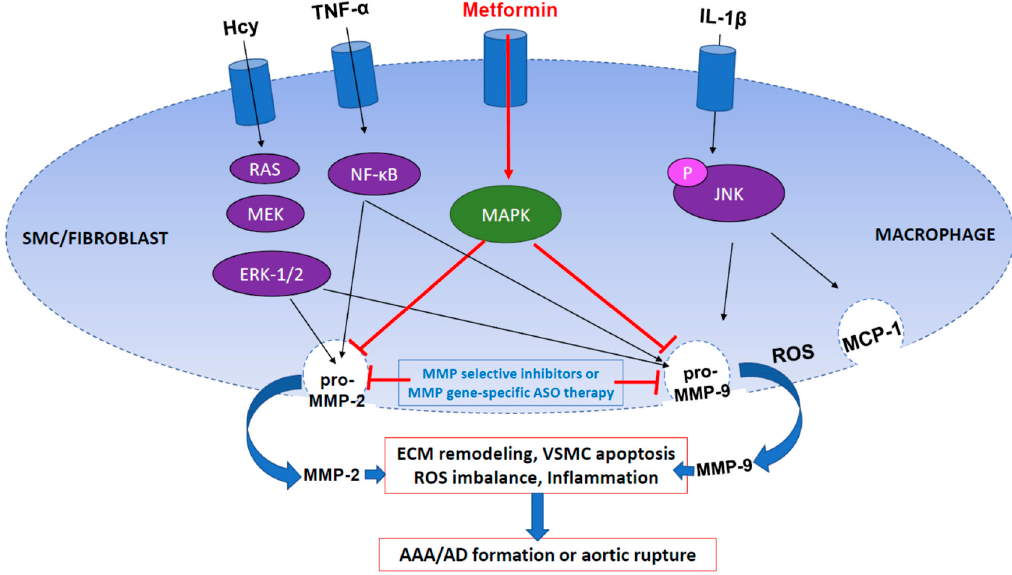
Figure 1. Signaling pathways involved in regulating MMP-2 and MMP-9 activity in VSMC/fibroblasts and macrophage, respectively. ASO: antisense oligonucleotide, Hcy: homocysteine, TNF- α : tumor necrosis alpha, IL-1 β : interleukin 1 beta, MCP-1: monocyte chemoattractant protein 1, ROS: reactive oxygen species.